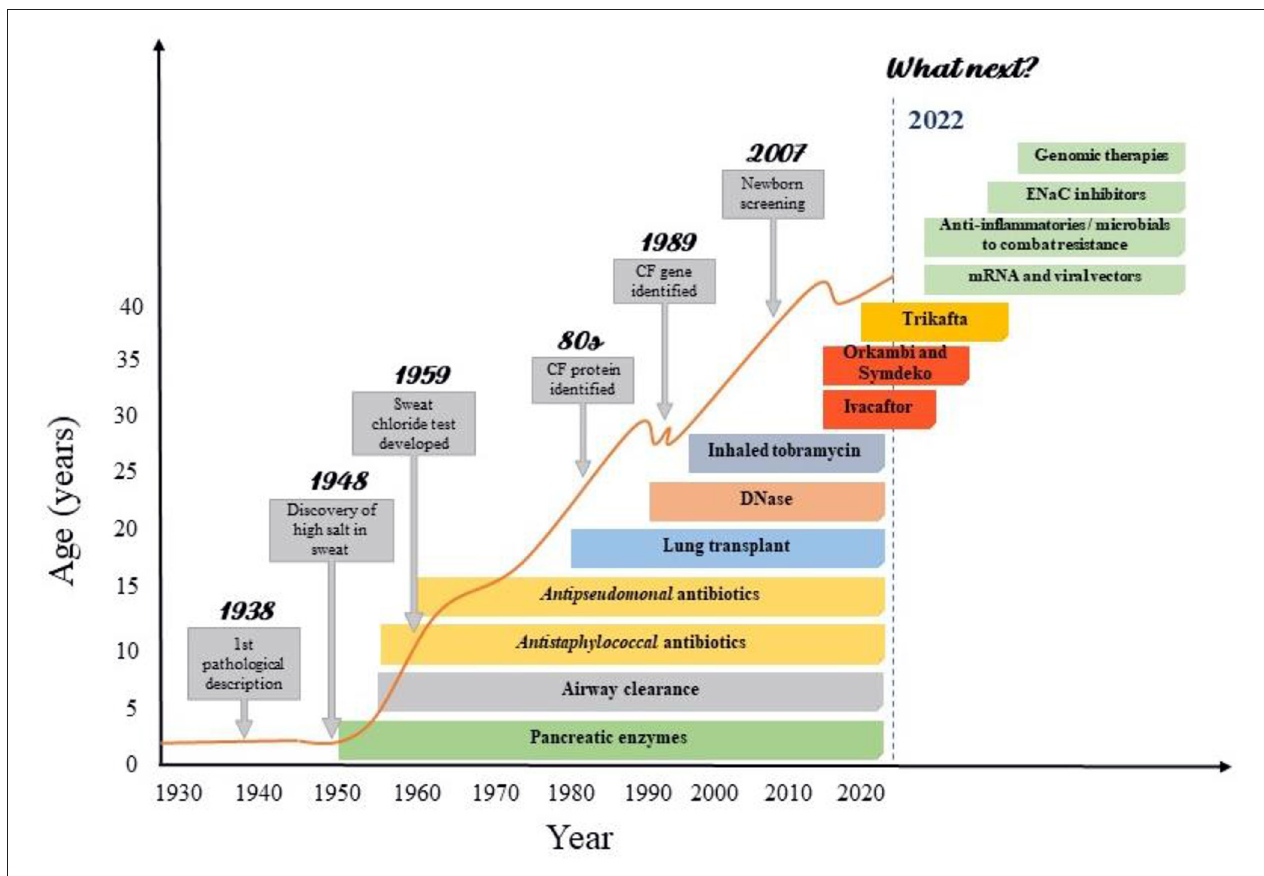
FIGURE 1 | Improvements in cystic fibrosis survival according with the advances CF care. Advances in CF care were resulted from increasing knowledge in basic sciences as genomics and proteomics. The successive advances in the understanding of the pathophysiology, symptoms and treatment achieved by basic research have made the care of patients with cystic fibrosis highly complex, involving protocols for screening, diagnosis and treatment. This has enabled significant gains in life expectancy, especially in recent decades. However, there are still many issues to be resolved in CF, which is why a great development of research with clinical repercussion is expected in the coming